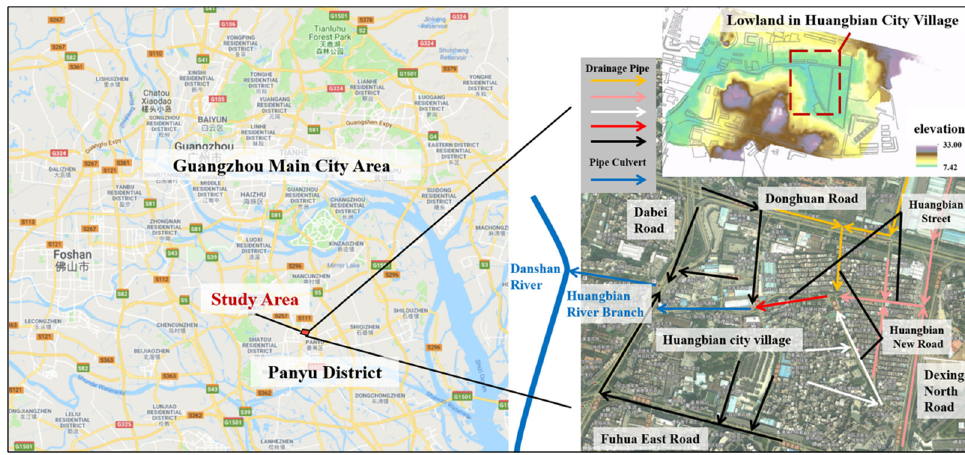
Figure 1. Location of the study